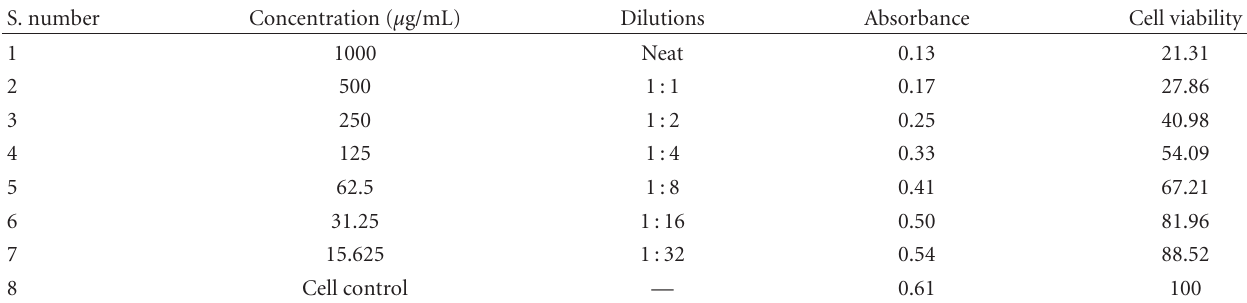
Table 1: Showing the e ff ect of anthocyanin on MCF-7 cells extracted from red sorghum bran by using methanol. S.